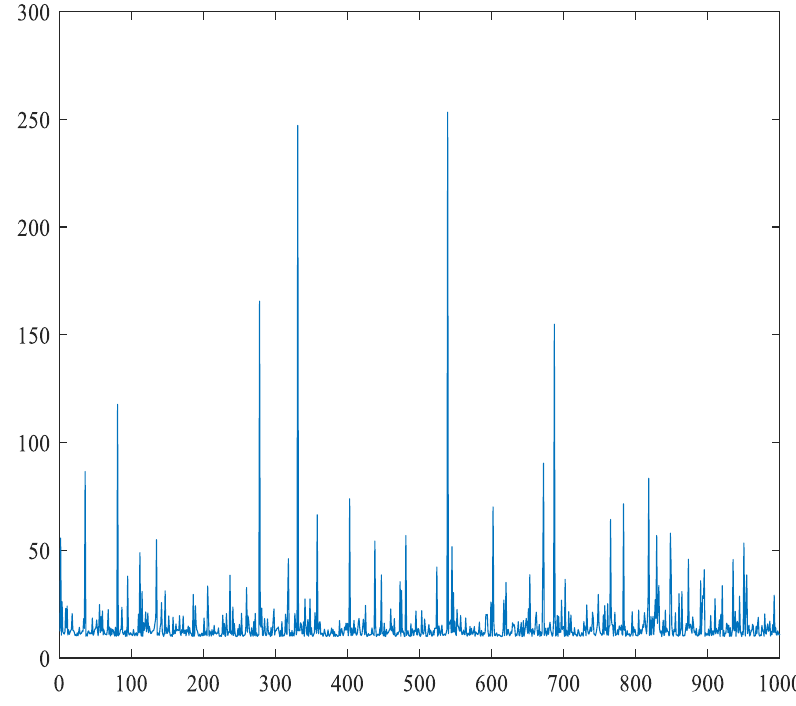
Figure 3. GP time series.